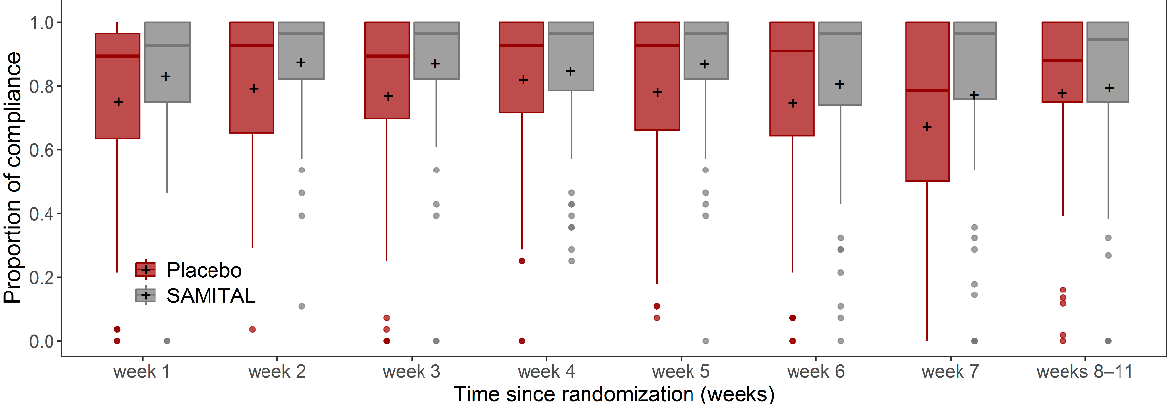
Figure 5. Box plot of overall compliance, defined as the number of sachets consumed out of those planned during radiotherapy (weeks 1 to 7) and 4 weeks after the end of radiotherapy (week 11). The heavy horizontal line represents the median; the box represents the interquartile range; the whiskers represent 95% confidence intervals; the circles represent outliers.